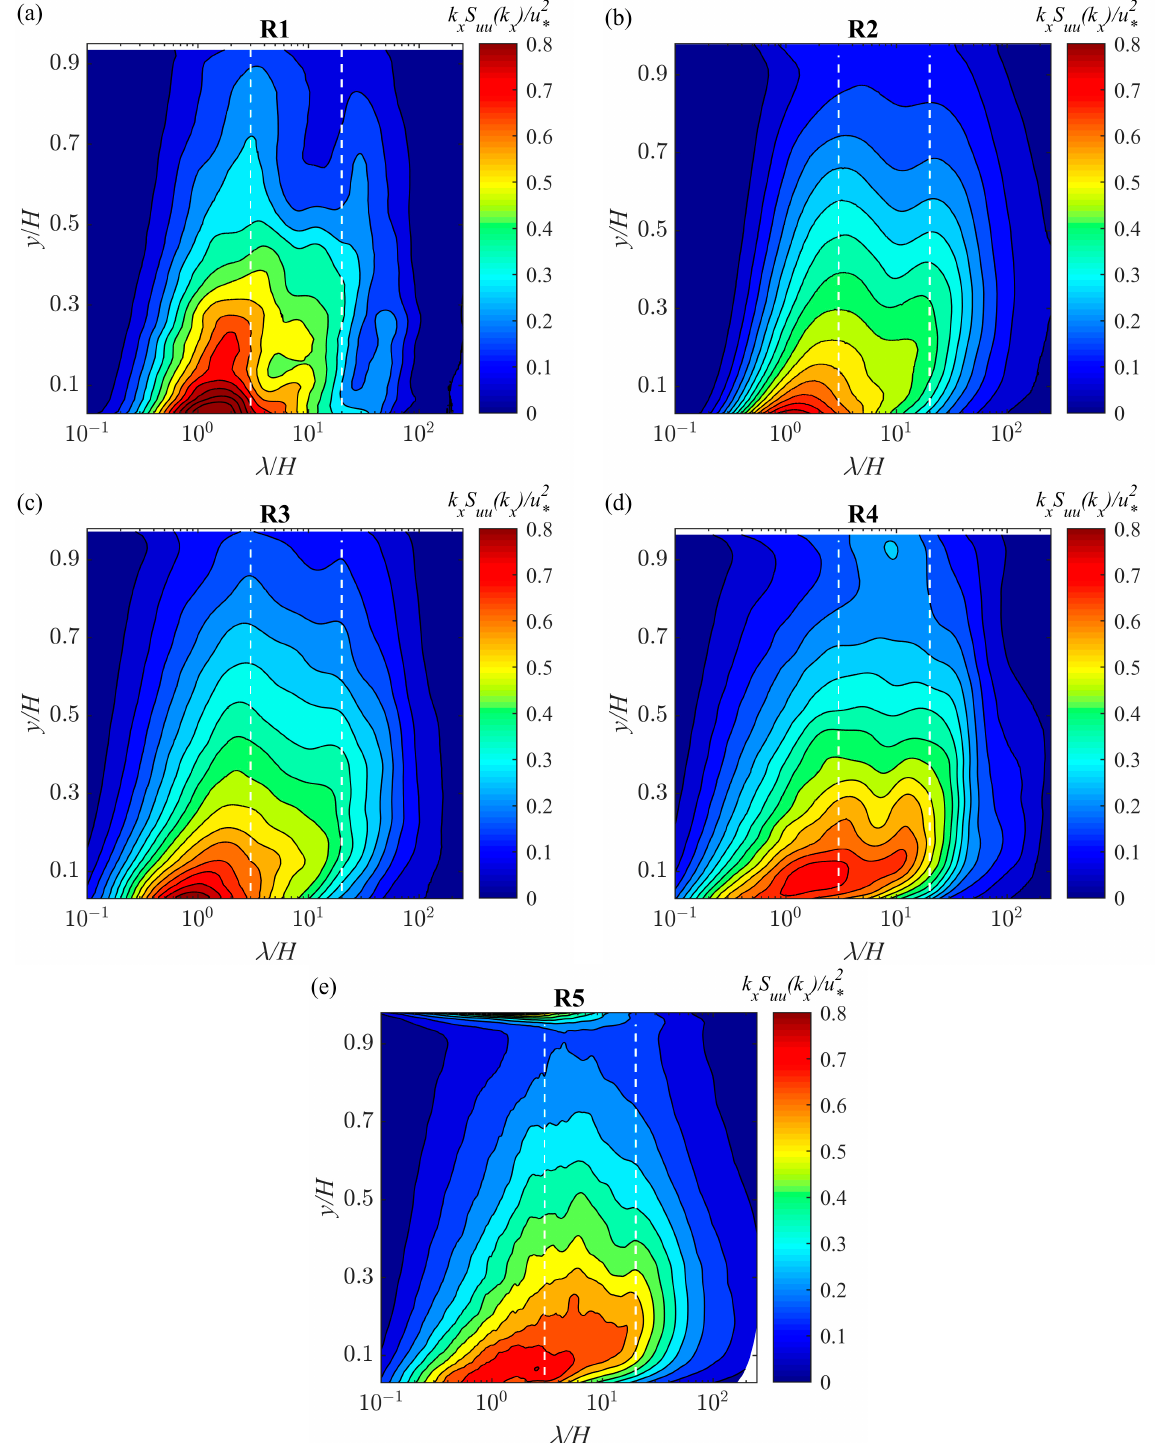
Figure 3. Premultiplied power spectra of streamwise velocity for runs: ( a ) R1, ( b ) R2, ( c ) R3, ( d ) R4 and ( e ) R5 .